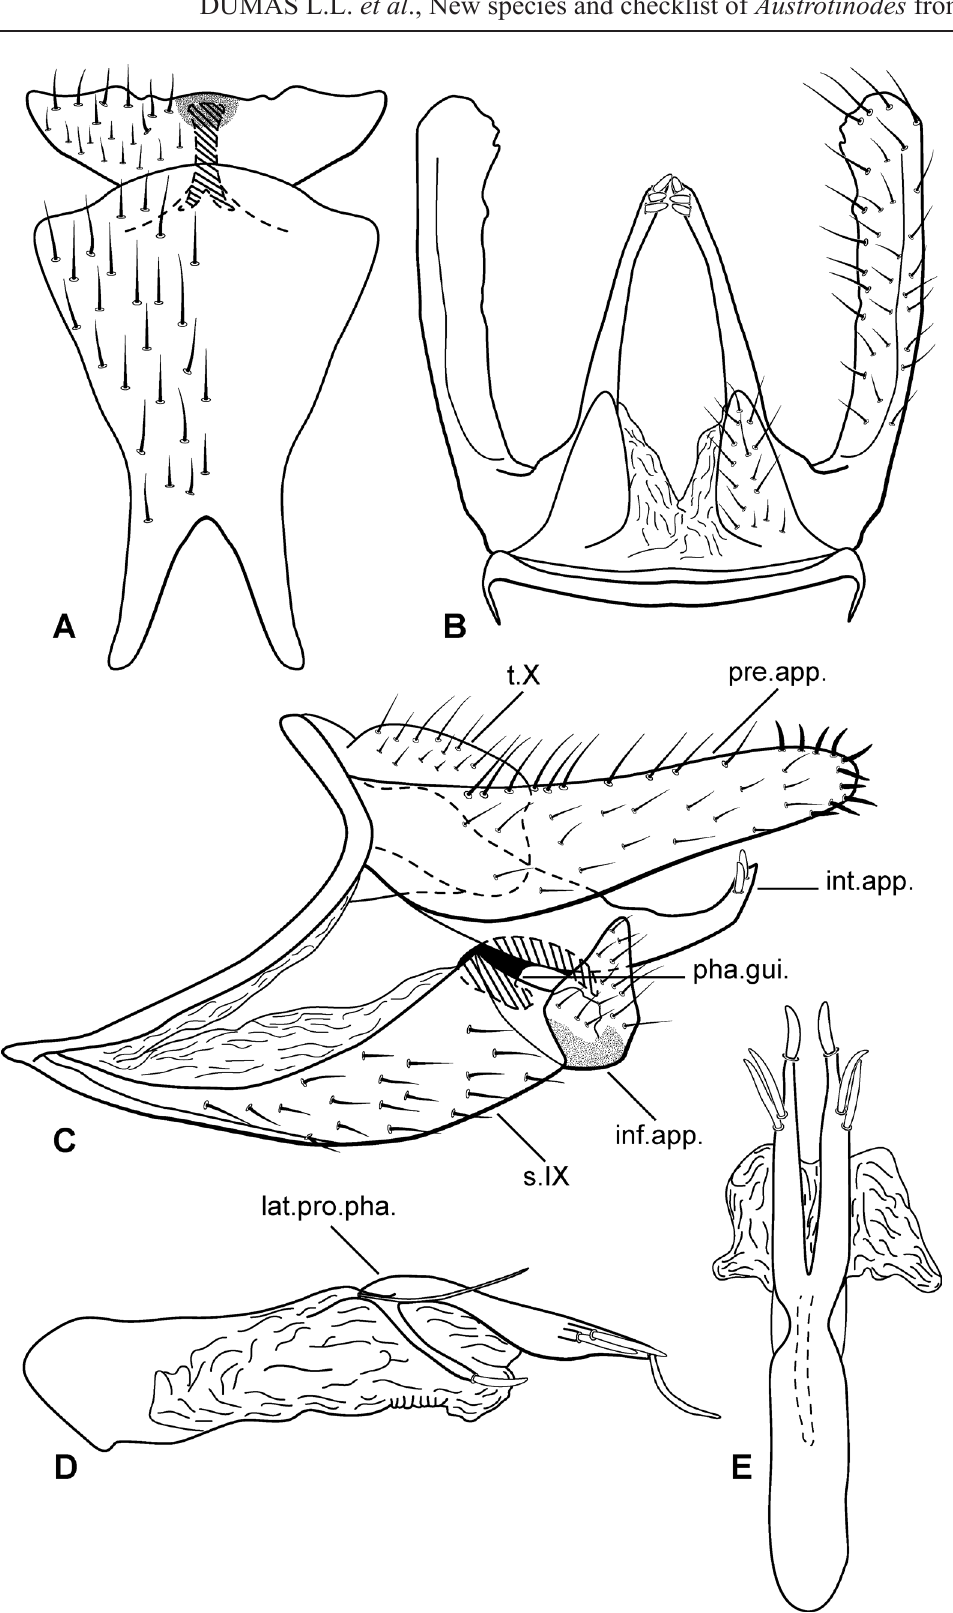
Fig. 1. Austrotinodes absaberi sp. nov., male genitalia. A . Ventral view. B . Dorsal view. C . Left lateral view. D . Phallic apparatus, left lateral view. E . Phallic apparatus, dorsal